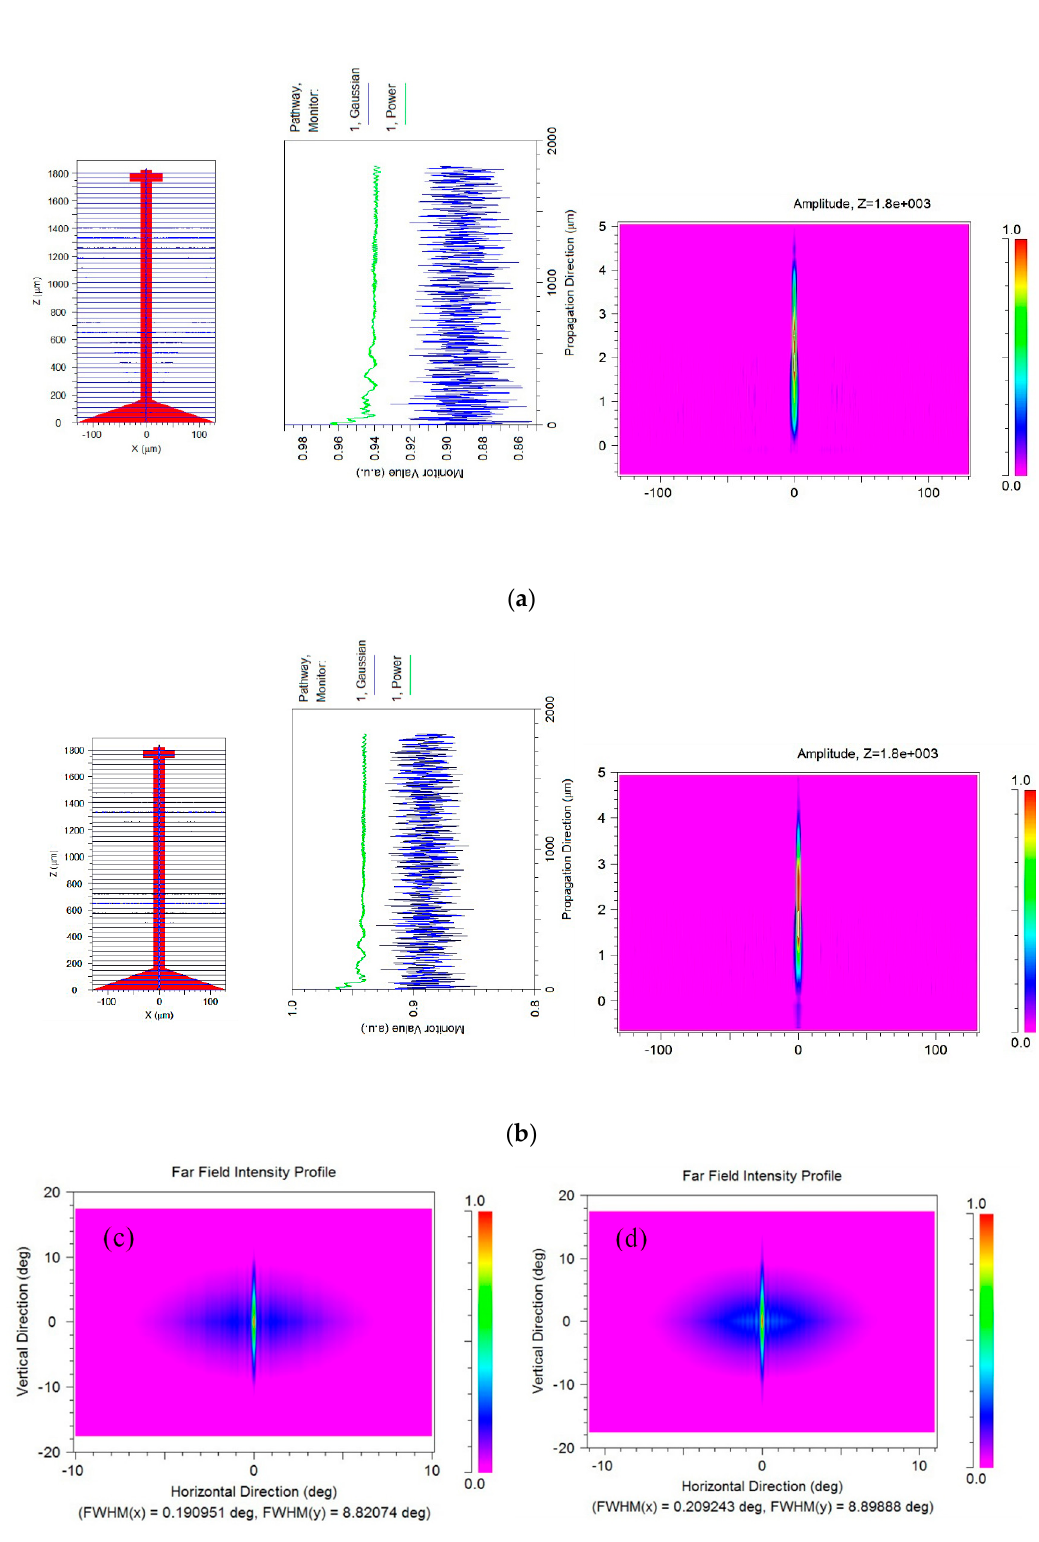
Figure 12. Wave propagation along the waveguide using a Gaussian beam profile for the 4 µ m core input fiber ( a ) operating at 0.4 µ m, ( b ) operating at 0.65 µ m, middle figure showing field amplitude profile at z = 1800 µ m (near the tip of the cantilever waveguide), ( c ) far field beam profile at λ = 400 nm and ( d ) 650 nm.